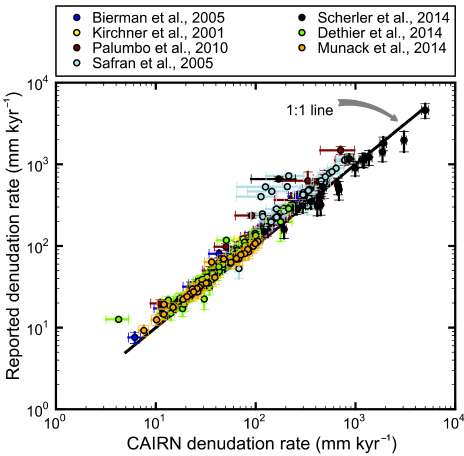
Figure 5. Comparison of denudation rates reported by selected studies plotted against denudation rates predicted by CAIRN. The denudation rates for individual studies use their original assump- tions of the density of the surface material, as reported in Table 3. The results from CAIRN in this plot use a density of 2.65gcm − 2 .